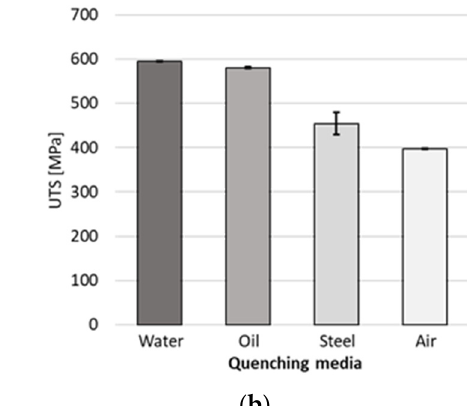
Figure 10. ( a ) Influence of quenching speed during PWHT on the UTS of the welding seam; ( b ) Influence of quenching speed on the UTS of the BM.